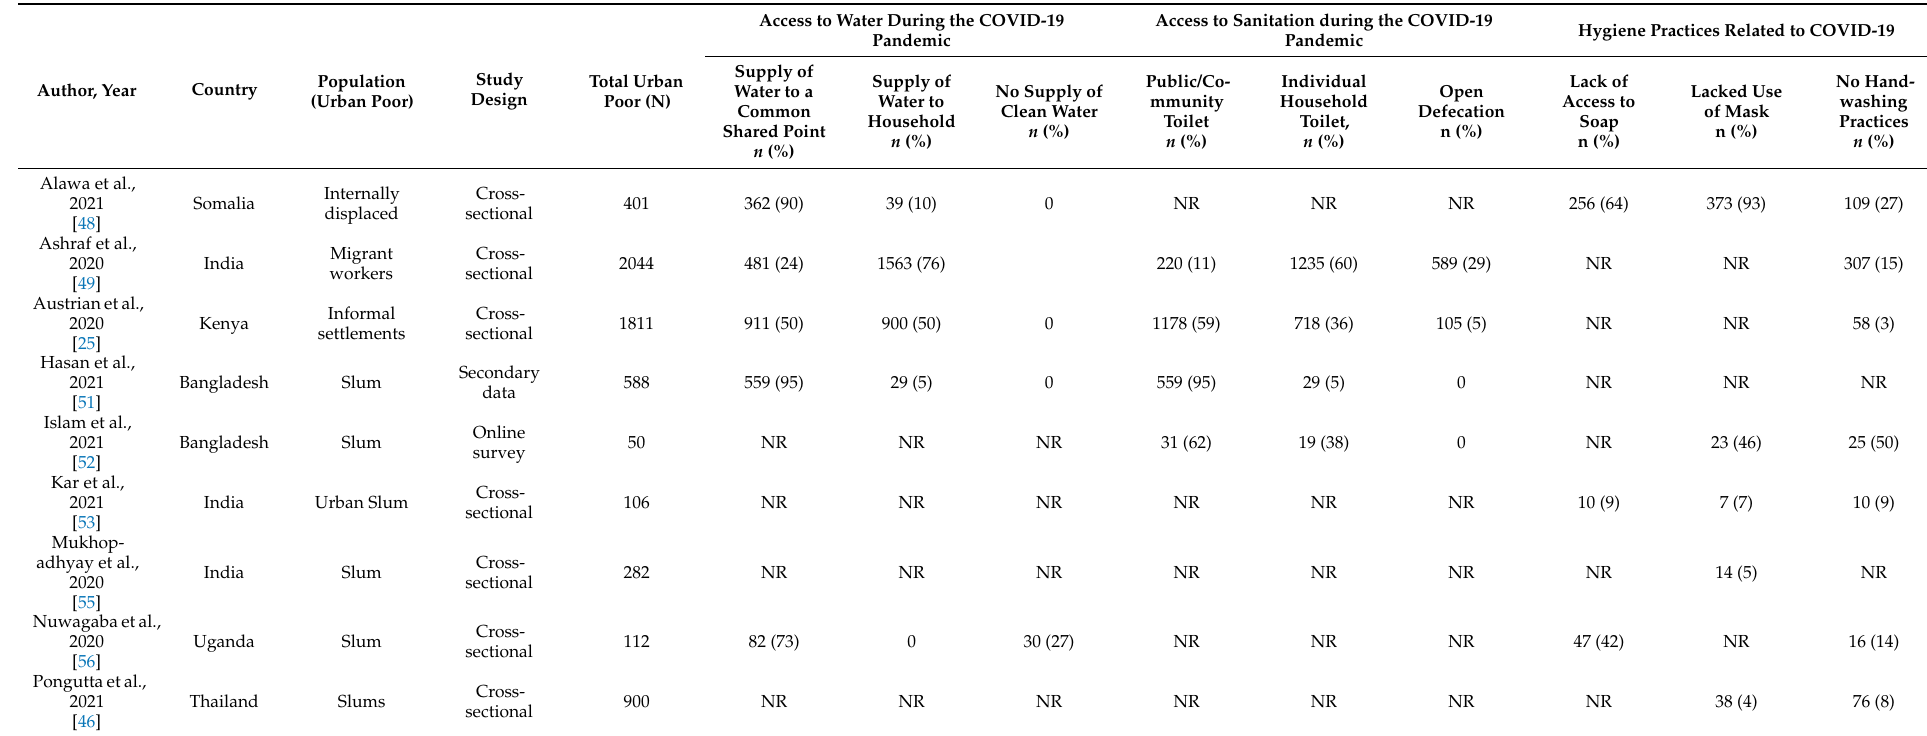
Table 2. Access to water, sanitation, and hand hygiene practices among the urban poor during the COVID-19 pandemic in